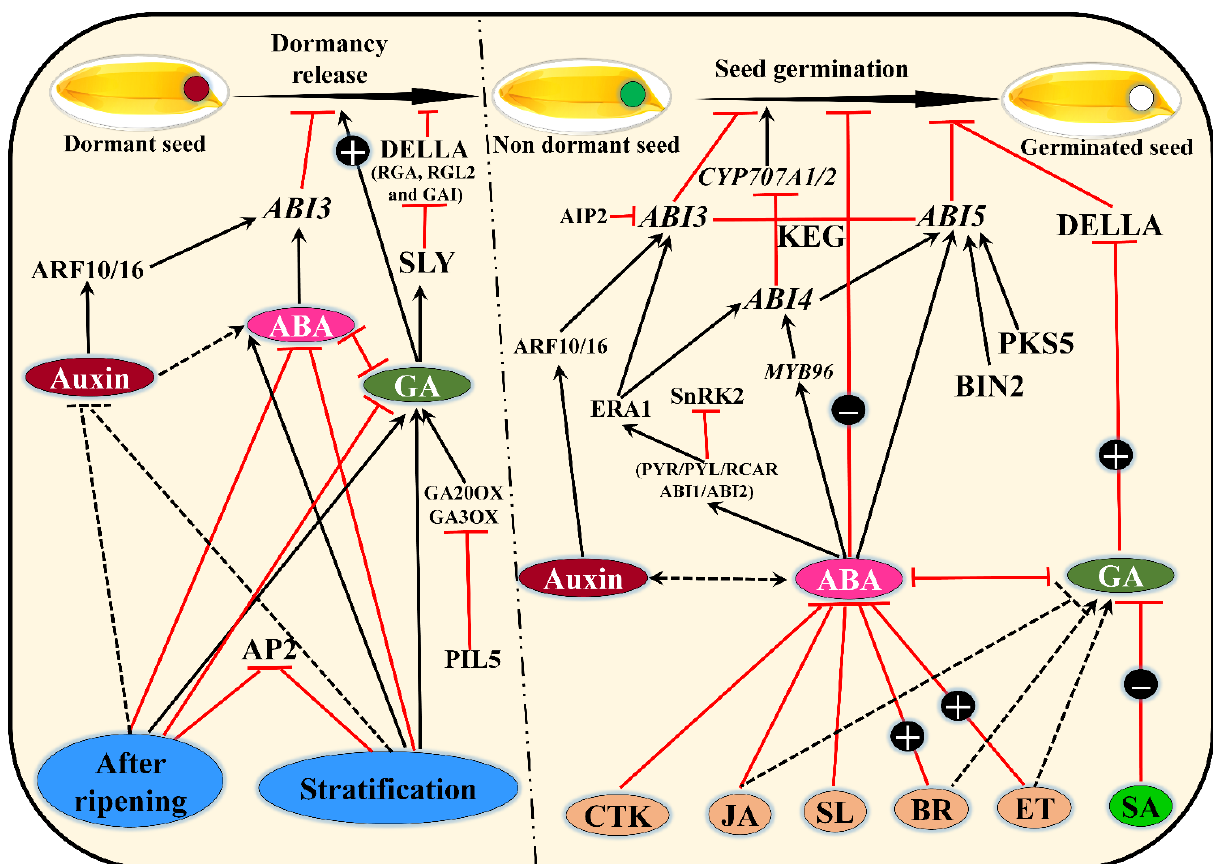
Figure 1. Regulatory phytohormone networks in seed dormancy and seed germination. Three major phytohormones, including auxin, abscisic acid (ABA), and gibberellin (GA), are key players in seed dormancy and germination. Mature seeds are dormant and contain a high level of ABA and a low level of GA. Several transcription factors (ABI4, DDF1, OsAP2-39, AP2, and CHO1) are involved in the seed dormancy stage by positively regulating (+) the accumulation of ABA and decreasing the GA content. While seed dormancy is broken, the seed becomes nondormant and the initiation of germination can start. At this stage, the ABA/GA balance is kept by positive and negative regulation signals of almost all other phytohormones, including ethylene (ET), brassinosteroids (BRs), jasmonic acid (JA), salicylic acid (SA), cytokinins (CTKs), and strigolactones (SLs). Here, transcription factors including ARFs, MYB96, ABI3, ABI4, and ABI5 regulate ABA biosynthesis by interacting with CYP707A1 and CYP707A2 , while GA-negative regulation (-) is ensured by DELLA genes. The balance is constantly maintained until the seed emergence